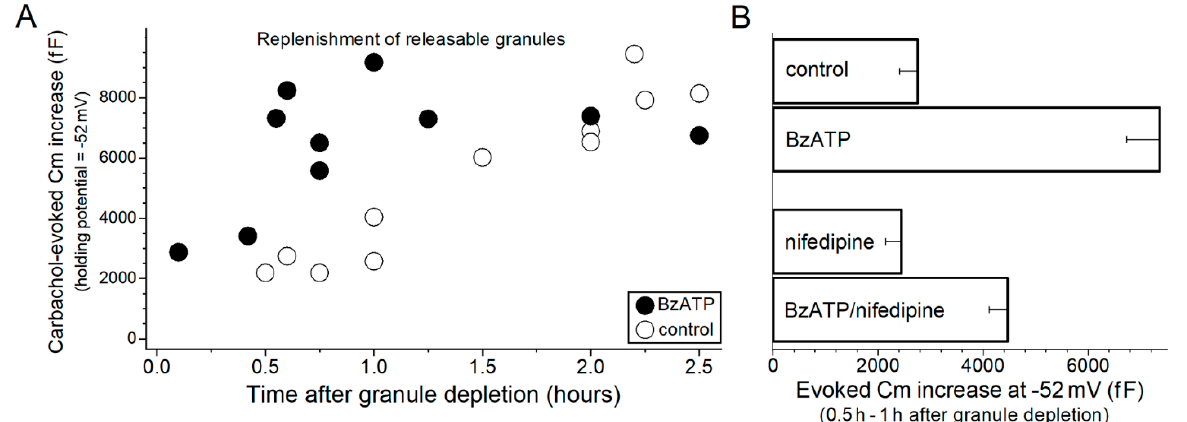
Figure 2. P2X 7 -induced acceleration of granule replenishment. ( A ), Time course for the replenishment of releasable granules. Conjunctival goblet cells were subjected to a granule-depleting protocol (see text) and subsequently incubated for various durations is a perfusate lacking (control) or containing 100 µM BzATP. Carbachol-evoked Cm increases were measured in goblet cells monitored at the holding potential of − 52 mV, a voltage at which a near-total emptying of releasable granules is evoked by carbachol (Figure 1D and Puro [9]). ( B ), BzATP-induced acceleration of granule replenishment in the absence or in the presence of the VGCC inhibitor, nifedipine. After administration of the granule depletion protocol, conjunctival specimens were bathed for 0.5 to 1 h under various conditions: in the standard perfusate (control; n = 5; data from Panel A), in this perfusate supplemented with 100 µM BzATP ( n = 5; data from Panel A), in the standard perfusate supplemented with the VGCC blocker nifedipine ( n = 4; 2 µM) or the standard perfusate supplemented with 100 µM BzATP plus 2 µM nifedipine ( n = 4). Indicative that a VGCC-dependent mechanism partially contributes to the BzATP-induced acceleration of granule replenishment, nifedipine diminished ( p = 0.0068) the evoked Cm increase measured in the BzATP-treated goblet cells. Of note, in the absence of BzATP, nifedipine did not significantly affect the evoked Cm increase. Indicative that the P2X 7 -induced boost in granule replenishment also involves a VGCC-independent mechanism, BzATP induced a significant acceleration ( p = 0.0047) in the presence of nifedipine.